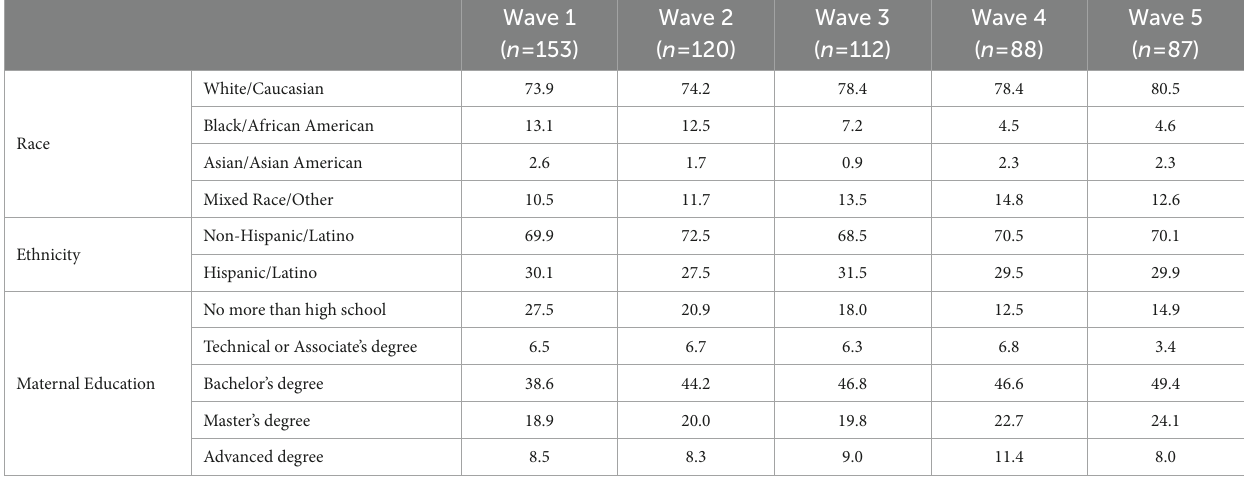
TABLE 1 Participant demographics (in percentages) across 5 years of data